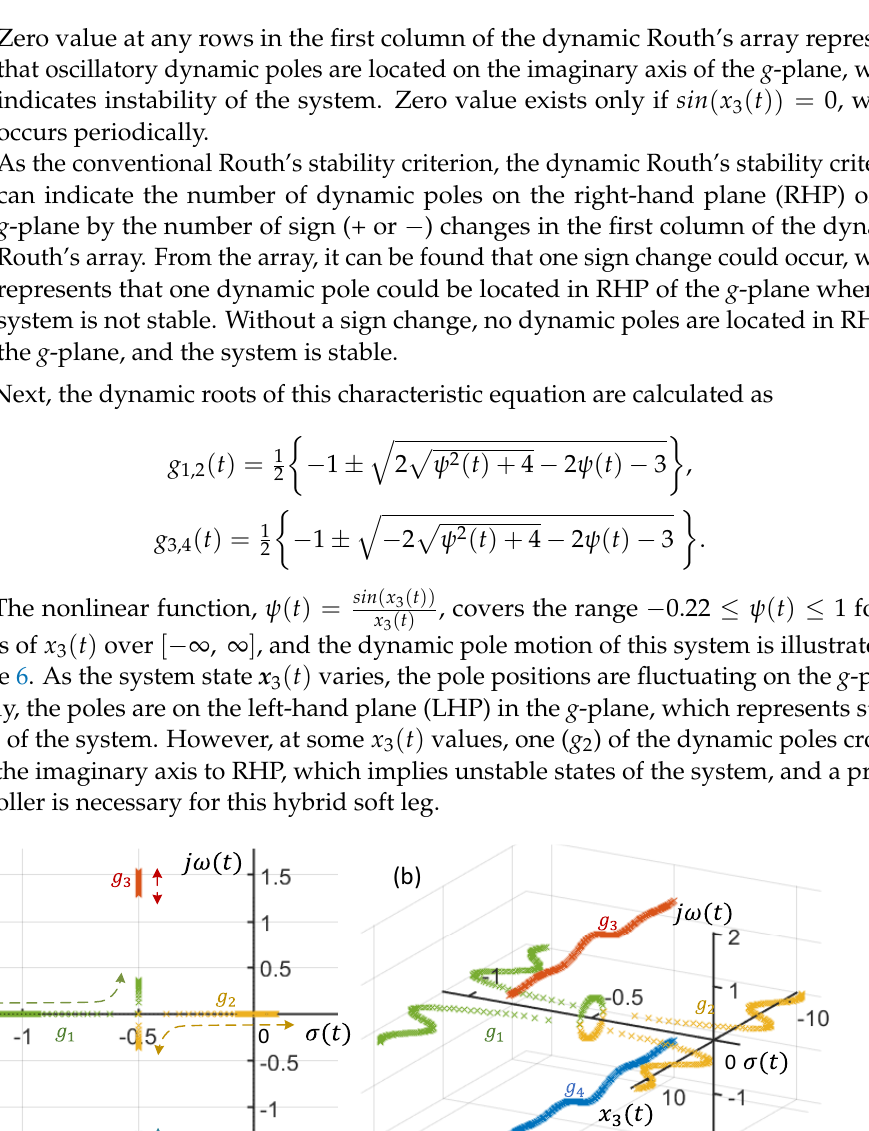
Figure 6. The sketch of dynamic pole motion (DPM) of the hybrid soft leg without a controller: ( a ) two-dimensional representation with 𝜎(𝑡) - and 𝑗𝜔(𝑡) -axes and ( b ) three-dimensional representation adding a 𝑥 3 (𝑡) -axis. The arrows in ( a ) indicate the paths of pole movements.